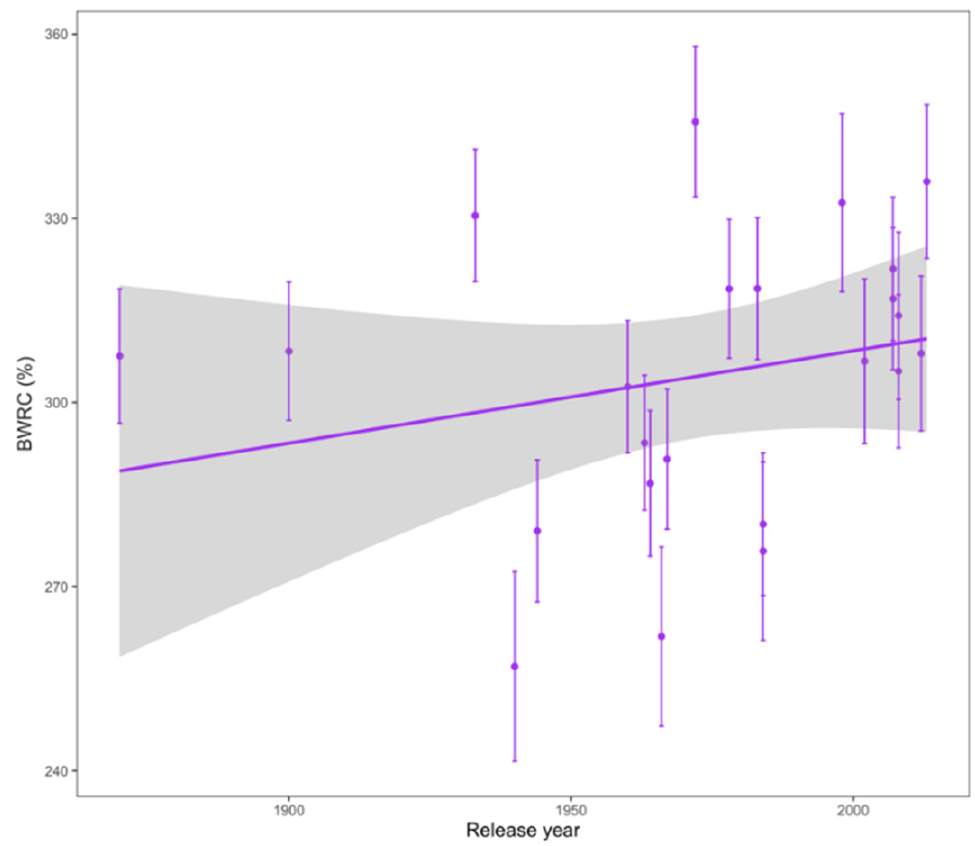
Figure 4. Bran water retention capacity (BWRC) with significant trends across release year. Least squares means are plotted across both harvest years. The gray shaded area shows the 95% confidence interval of the regression line.